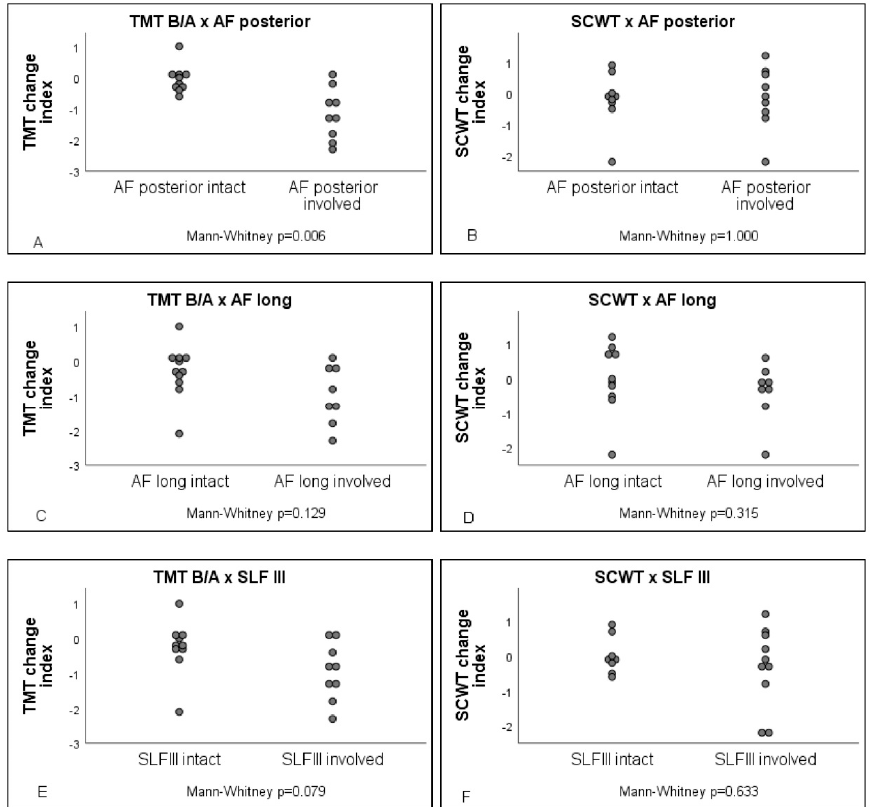
Figure 1. TMT B/A and SCWT change index in relation to white matter tracts. Involvement of the posterior part of AF in ( A ) TMT performance and in ( B ) SCWT performance; involvement of the longitudinal part of AF in ( C ) TMT performance and ( D ) SCWT performance; involvement of the SLF III in ( E ) TMT performance and ( F ) SCWT involvement.